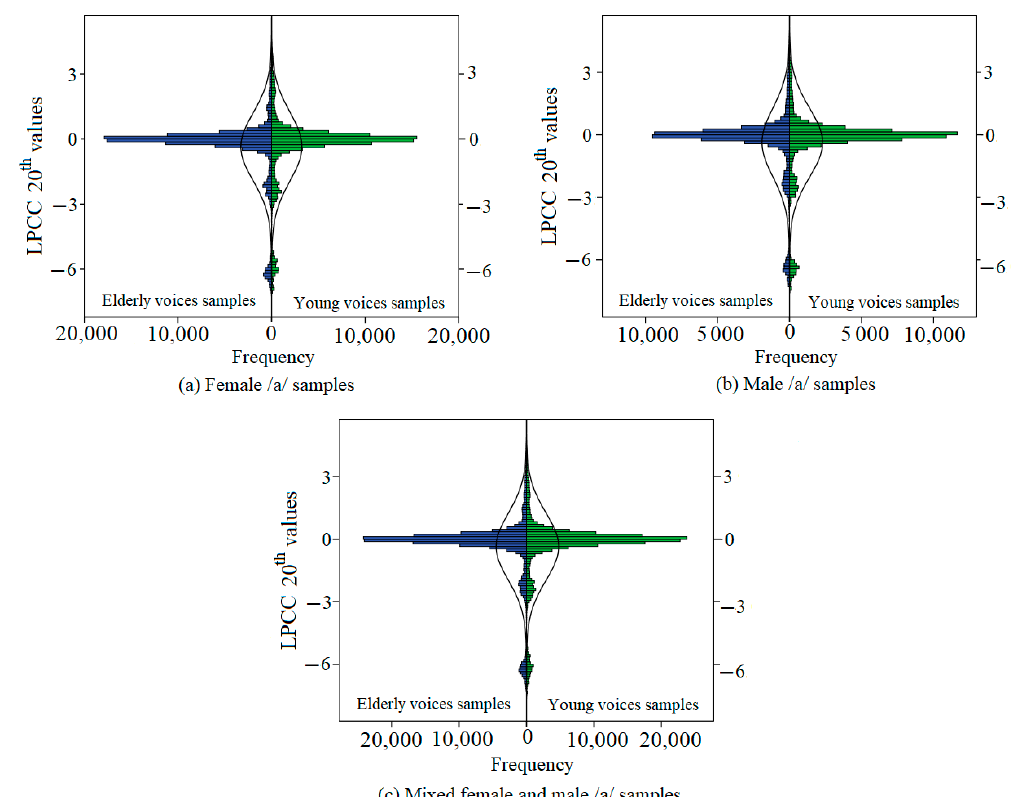
Figure 2. Histograms of the 20-dimensional LPCCs extracted from elderly and young voices.